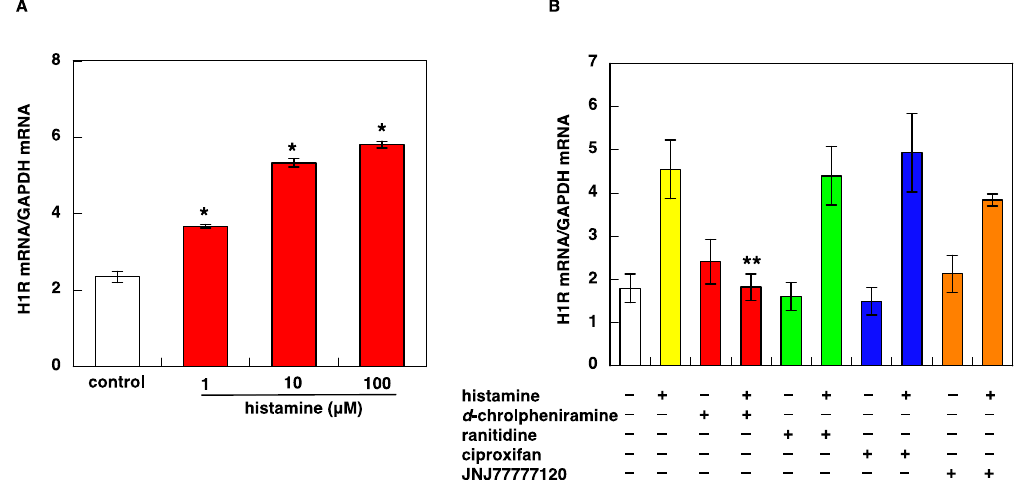
Figure 1. Stimulation with histamine causes upregulation of H1R mRNA expression through H1R activation in U-373 MG cells. ( A ) Dose-dependent study of histamine-induced H1R mRNA upregulation. U-373 MG cells were starved in serum-free medium for 24 h before treatment with various concentrations of histamine. H1R mRNA was determined by quantitative RT-PCR 3 h after histamine treatment. Data are represented as means ± SEM ( n = 3). * p < 0.05 vs. control. ( B ) Effects of histamine receptor antagonists on histamine-induced H1R mRNA upregulation. Histamine receptor antagonists (1 µ M each) were treated 1 h before stimulation with 100 µ M histamine. Antagonists used are as follows, d -chlorpheniramine (H1R antagonist), ranitidine (H2R antagonist), ciproxifan (H3R antagonist), and JNJ777120 (H4R antagonist). Data are represented as means ± SEM ( n = 9). ** p < 0.01 vs. histamine. For statistical analysis, one-way ANOVA with Tukey–Kramer’s test was used.